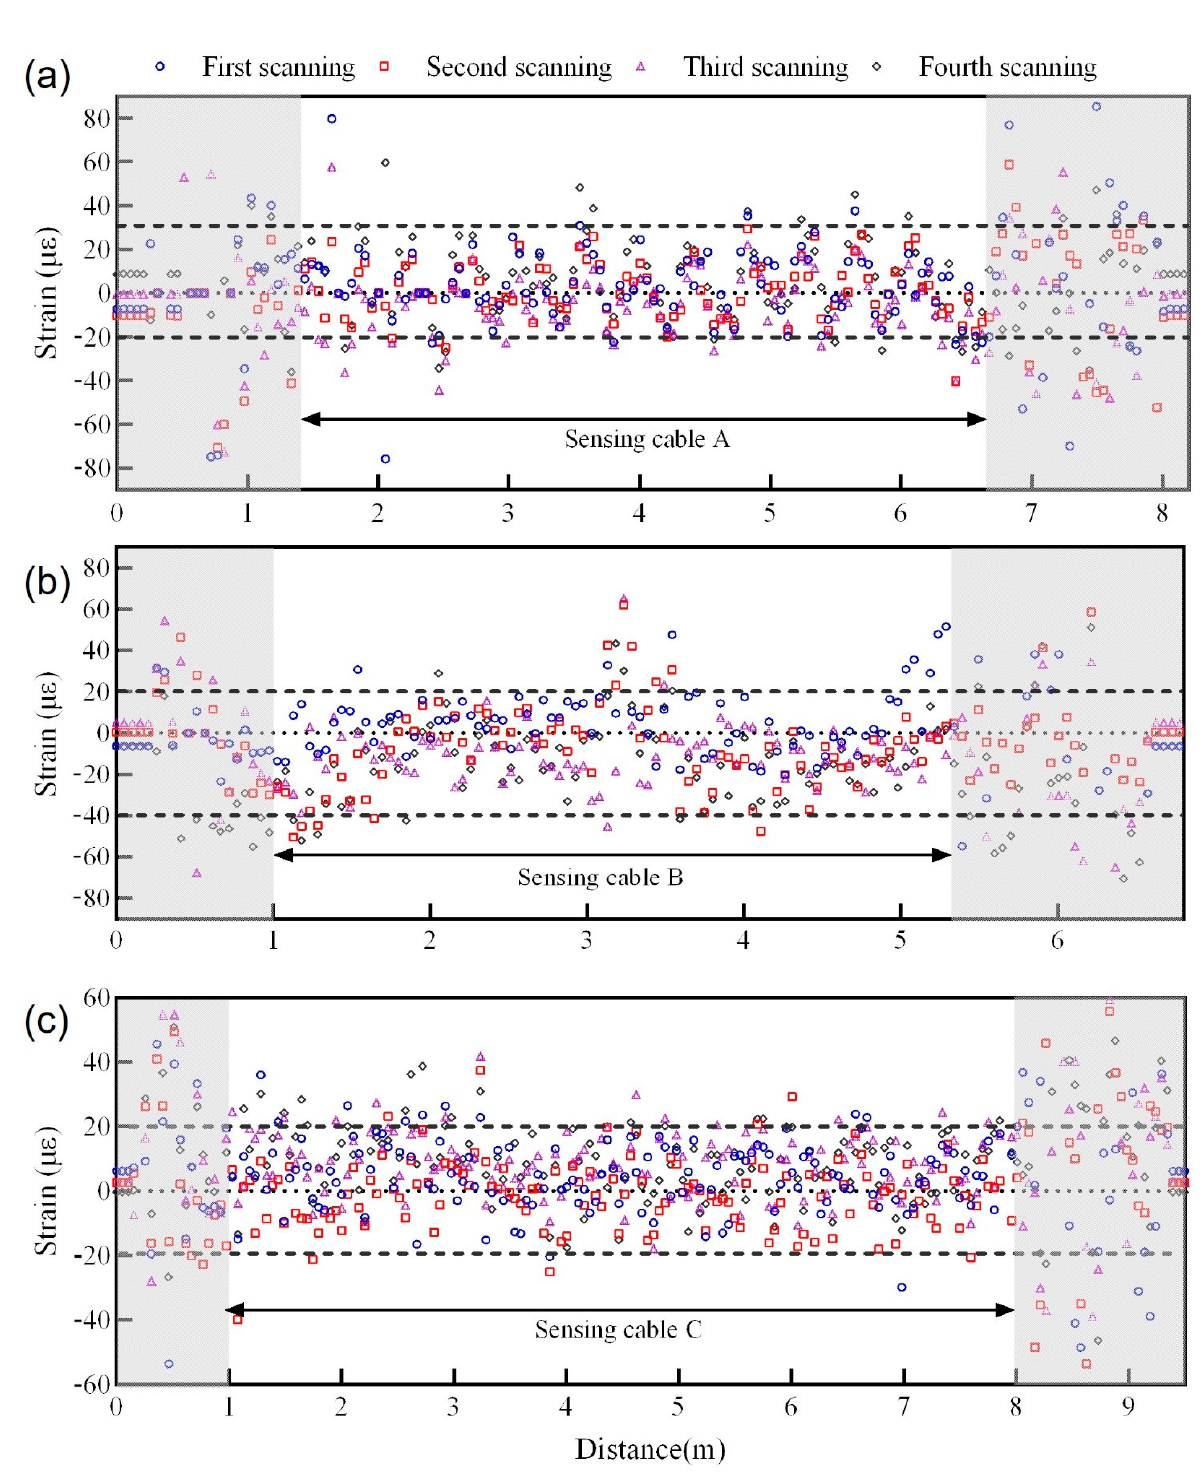
Figure 6. Distribution of the strain measurement error for the BOTDA interrogator for sensing cables A, B, and C.